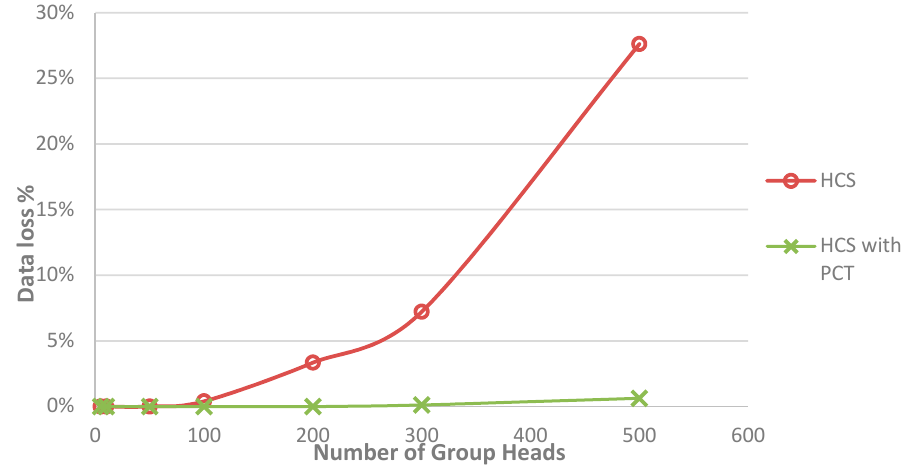
Figure 5. Comparing the data loss percentage using Hilbert Collection Strategy and different participating strategy.